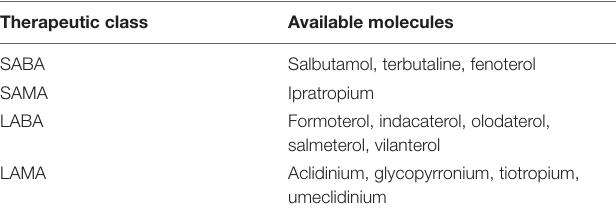
TABLE 2 | Non-exhaustive list of bronchodilator molecules used in the treatment of chronic obstructive respiratory disorders and corresponding therapeutic class. Therapeutic class Available